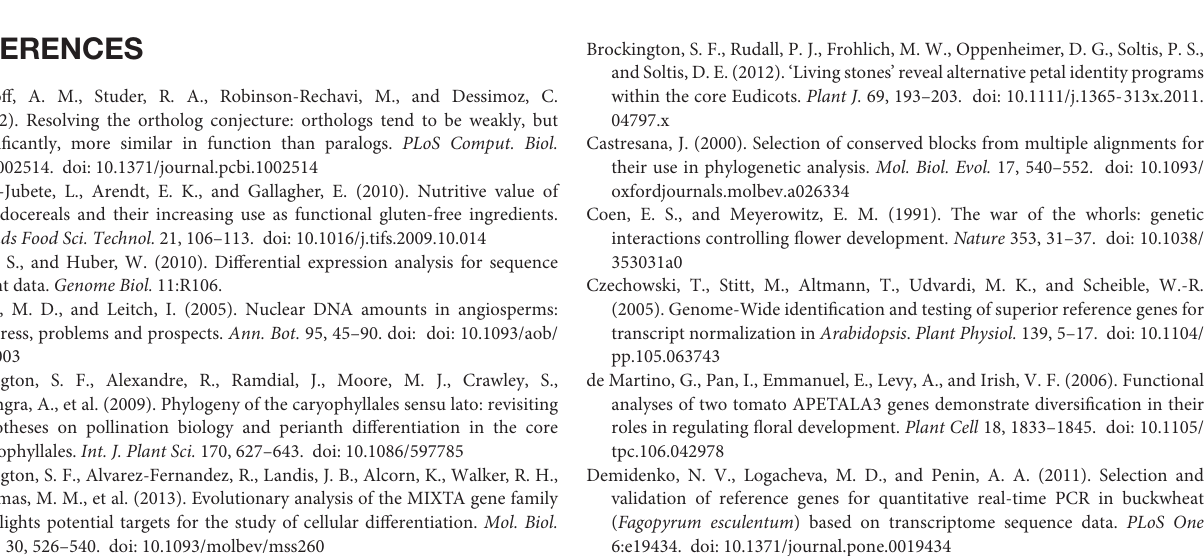
Supplementary Figure 2 | The distribution of Shannon entropy across expressed genes of F. esculentum. Supplementary Figure 3 | Heatmap showing tissue-specific (Shannon enthropy cut-off 0.25) buckwheat genes. For each gene expression values were normalized by maximal value. Supplementary Figure 4 | Heatmap showing the expression profiles of the genes – orthologs of the stably expressed genes in Arabidopsis thaliana . Supplementary Figure 5 | Heatmap showing the expression of buckwheat MYB genes sharing significant similarity with MIXTA/MYB16/MYB106. Supplementary Figure 6 | Phylogenetic tree of angiosperm MIXTA/MIXTA-like genes. Supplementary Table 1 | Data generated for the de novo assembly of the buckwheat genome and accession numbers of raw reads. Supplementary Table 2 | Statistics of the assembly. Supplementary Table 3 | Statistics for the presence of universal single-copy orthologs for the earlier assembly of the buckwheat genome and for the assembly reported in our study. Supplementary Table 4 | Statistics of the protein-coding gene annotation. Supplementary Table 5 | Transcription factor genes annotated in the buckwheat genome. Supplementary Table 6 | List of the samples included in the transcriptome mapping procedure and accession numbers of the raw reads. Supplementary Table 7 | Samples included in the transcriptome mapping procedure and correlations. Supplementary Table 8 | GO enrichment of the genes with broadest and narrowest expression